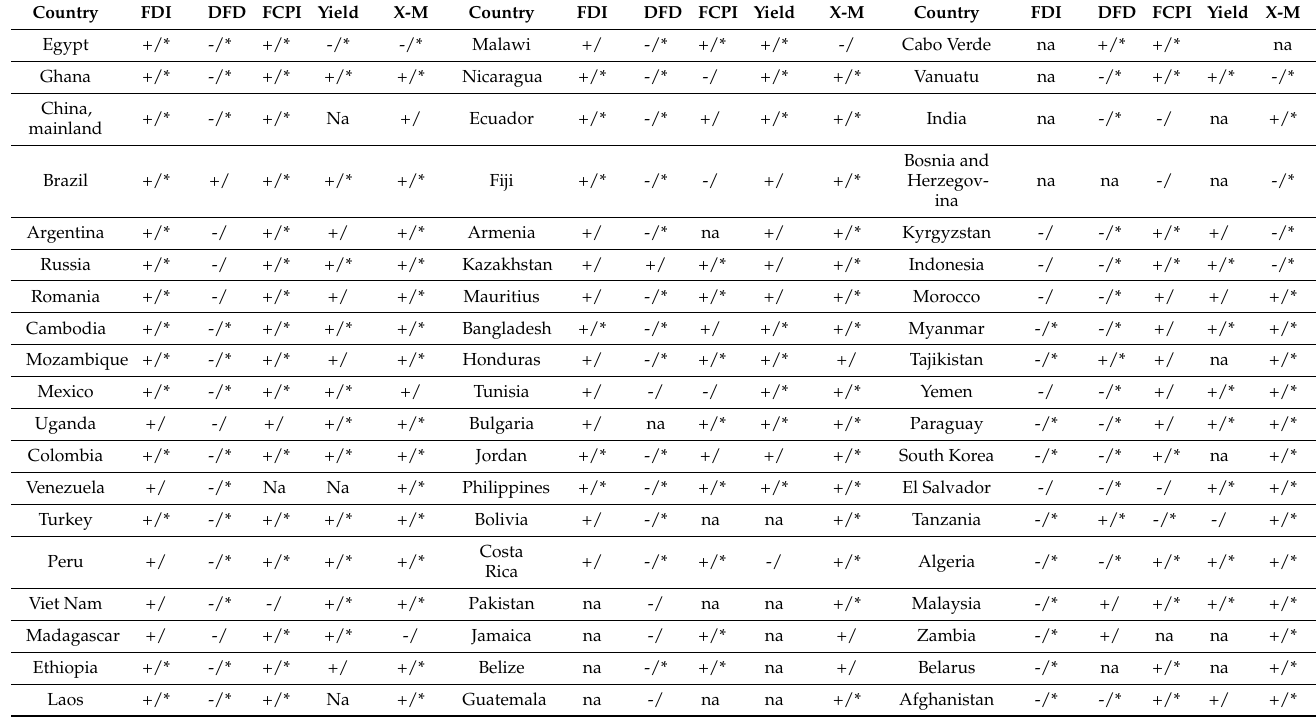
Table 2 attempts to take a casual look at the relationship between FDI in agriculture and food deficit and yield per hectare. We considered three indicators of food deficit: the difference between average calorie requirement per person and the actual intake (depth of food deficit—DFD), the consumer price index of food, and net export of crop and livestock. The first indicator appears to be sufficient to capture a country’s food deficit (Santangelo 2018). However, two issues are: first, the depth of food deficit may rise in a country where food availability is generally increasing due to unequal food distribution. Second, if CF produces and exports cash crops, food imports are financed through it, and food deficit may fall in the face of shrinking domestic food production. To tackle the first problem, we considered a second possible indicator of food deficiency—the food CPI. Table 2. Trends in Indicators of Food Deficit and FDI in Agriculture, Forestry, and Fishing in Developing